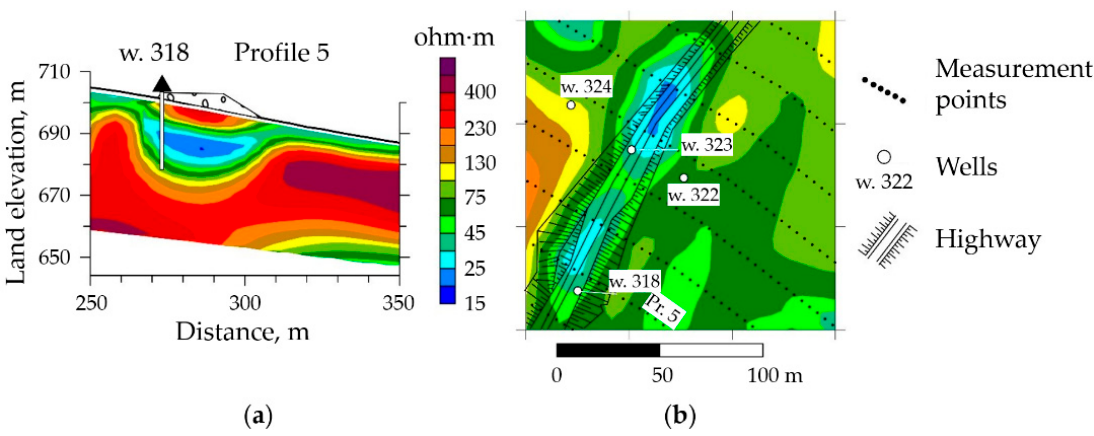
Figure 3. Fragment of the geoelectric section along the profile 5 ( a ) and that of the resistivity distribution map at a 15 m depth ( b ).